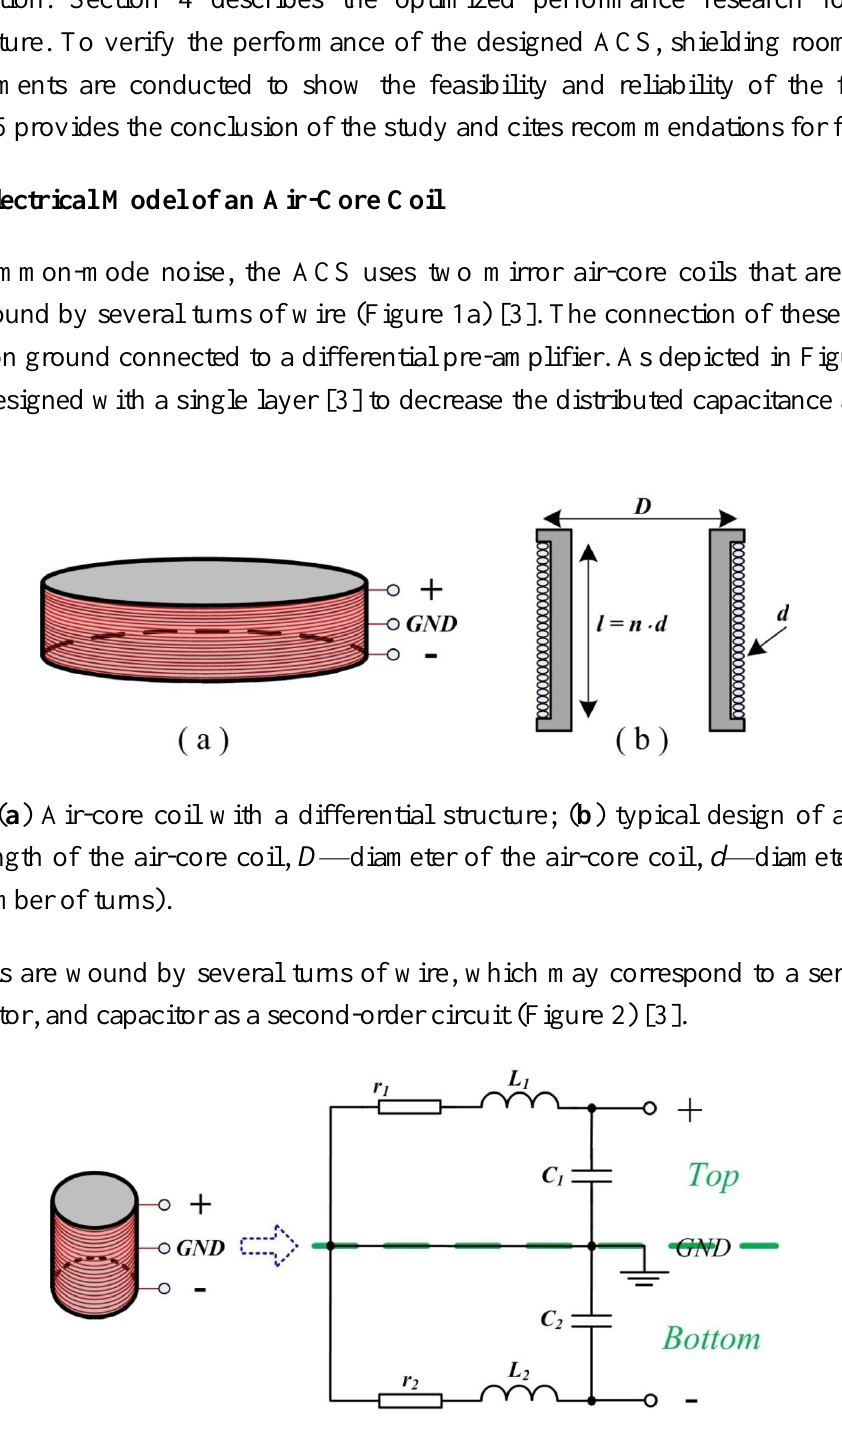
Figure 2. Schematic of the air-core coil, where r , L , and C are the resistance, inductance, and capacitance of the air-core coil,